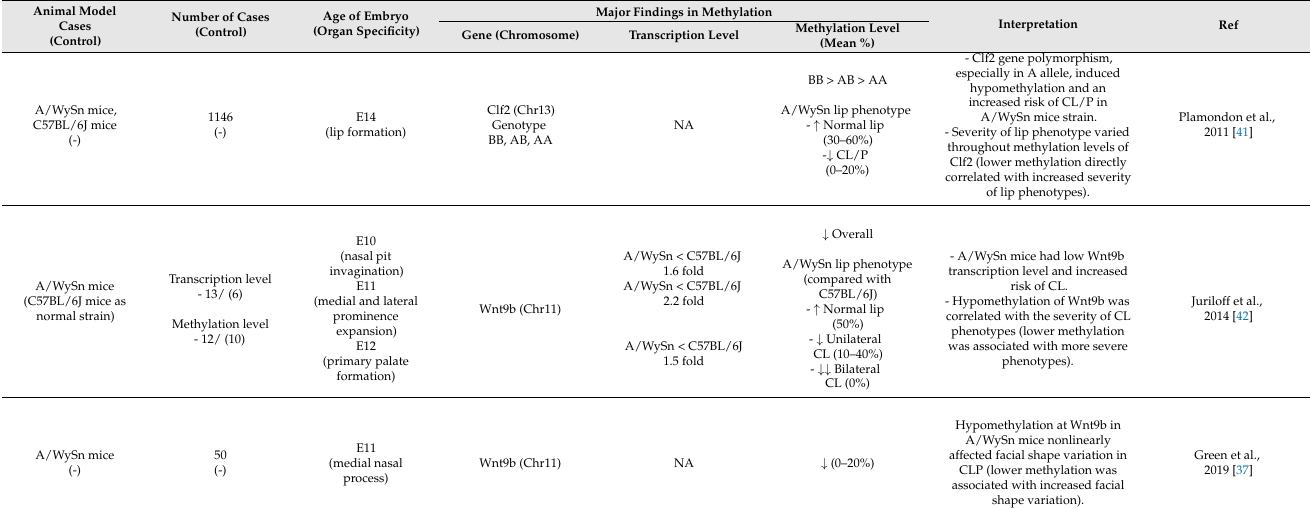
Table 3. Alterations in DNA methylation in animals with a genetically induced orofacial